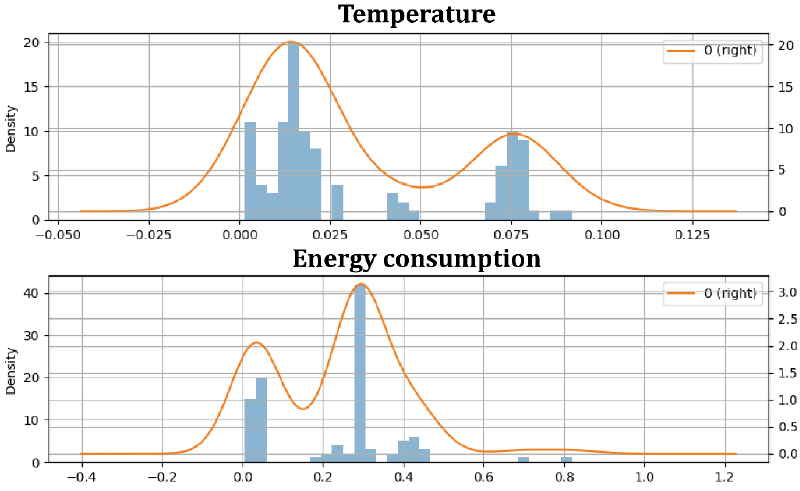
Figure 8. The normality test of the overall CVRMSE result data for energy consumption.